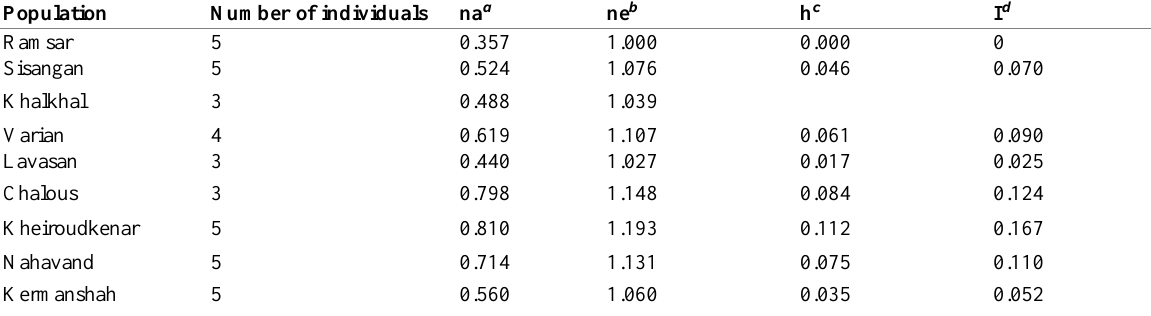
Table 9. Genetic diversity parameters in studied violet populations. Population